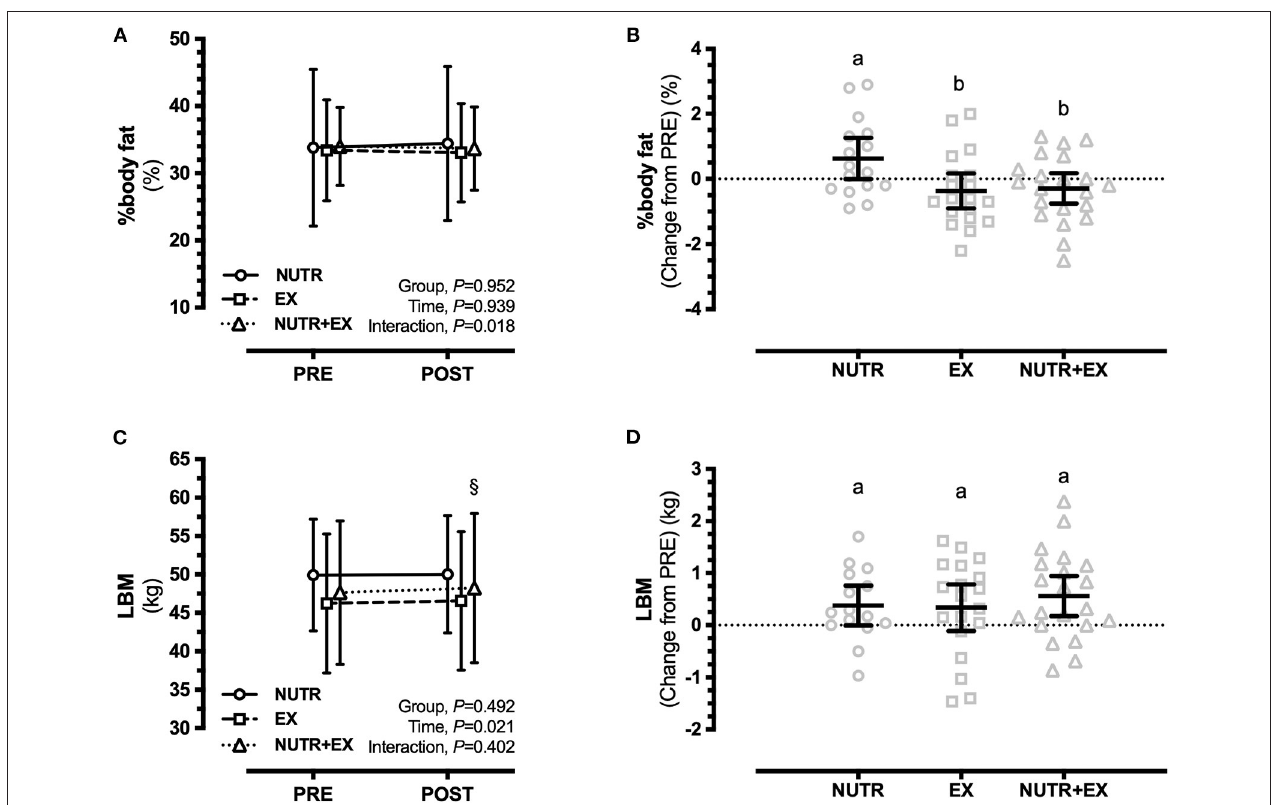
FIGURE 2 | Changes in body composition assessed by DXA in response to 12 weeks of concurrent aerobic and resistance exercise training with or without dietary intervention. (A) Group mean ± SD for percentage body fat; (B) Individual data points and mean difference with 95%CI for gain scores from PRE for percentage body fat; (C) Group mean ± SD for LBM; (D) Individual data points and mean difference with 95% CI for gain scores from PRE for LBM. § denotes significant difference from PRE to POST within NUTR + EX; § P < 0.05. Dissimilar letters demonstrate between-group differences ( P < 0.05) in panels (B,D)